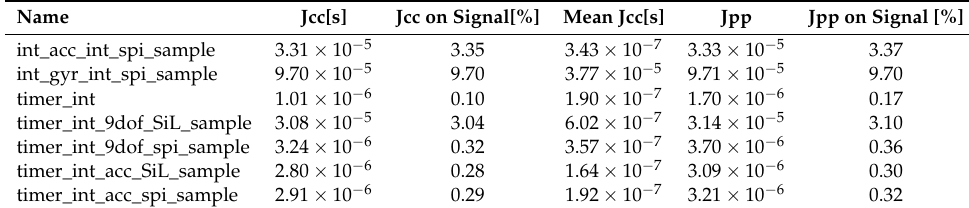
Table 5. Cycle-to-Cycle-Jitter without optimization